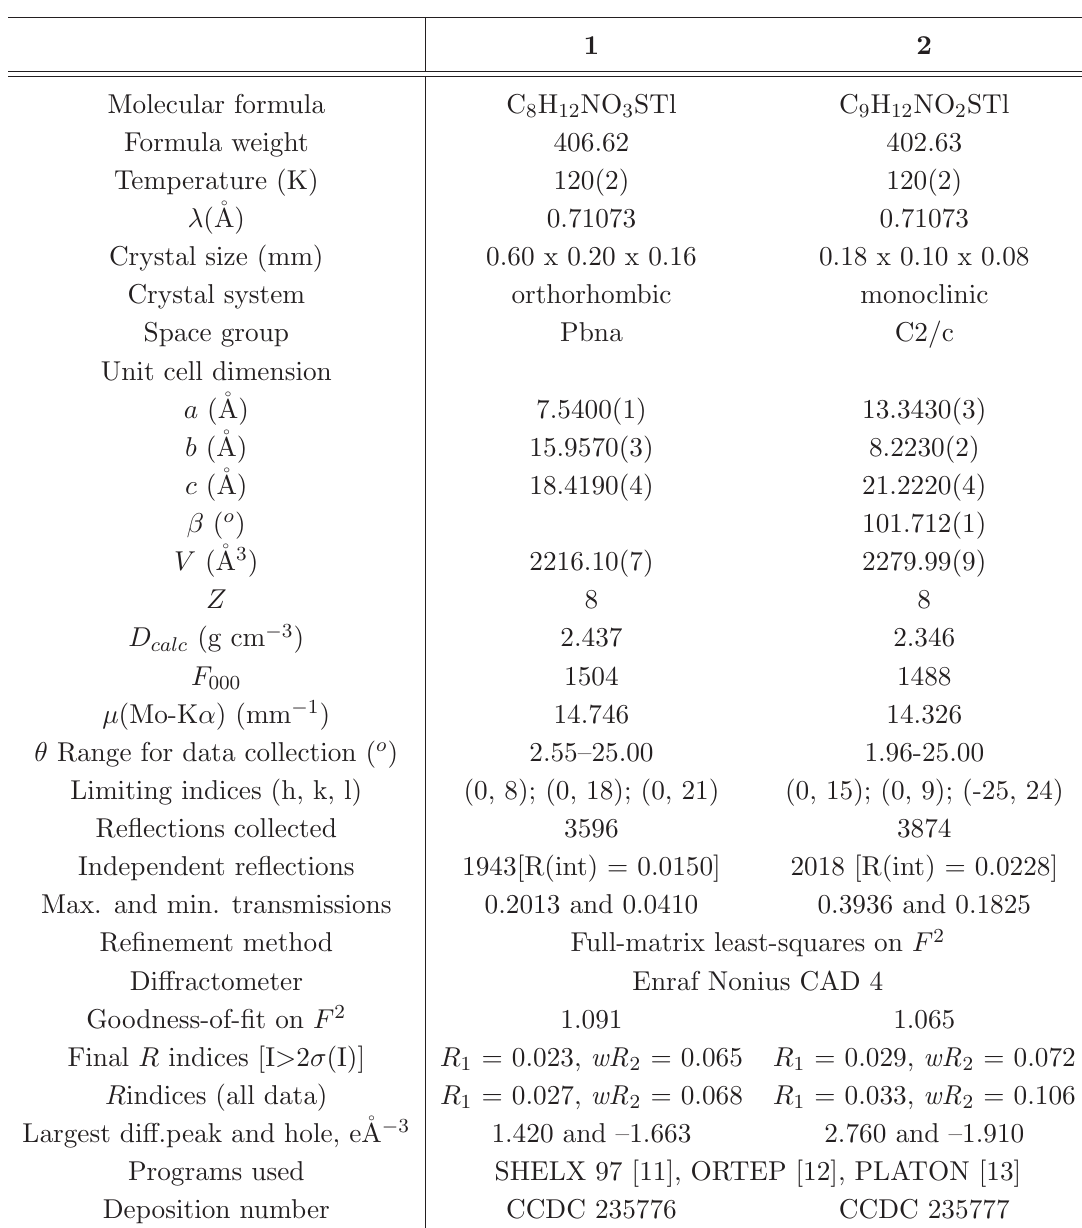
Table 3 Crystal data and details of the structure refinement for [TlMe 2 (2mna)] · H 2 O ( 1 ) and [TlMe 2 (2mmn)] ( 2